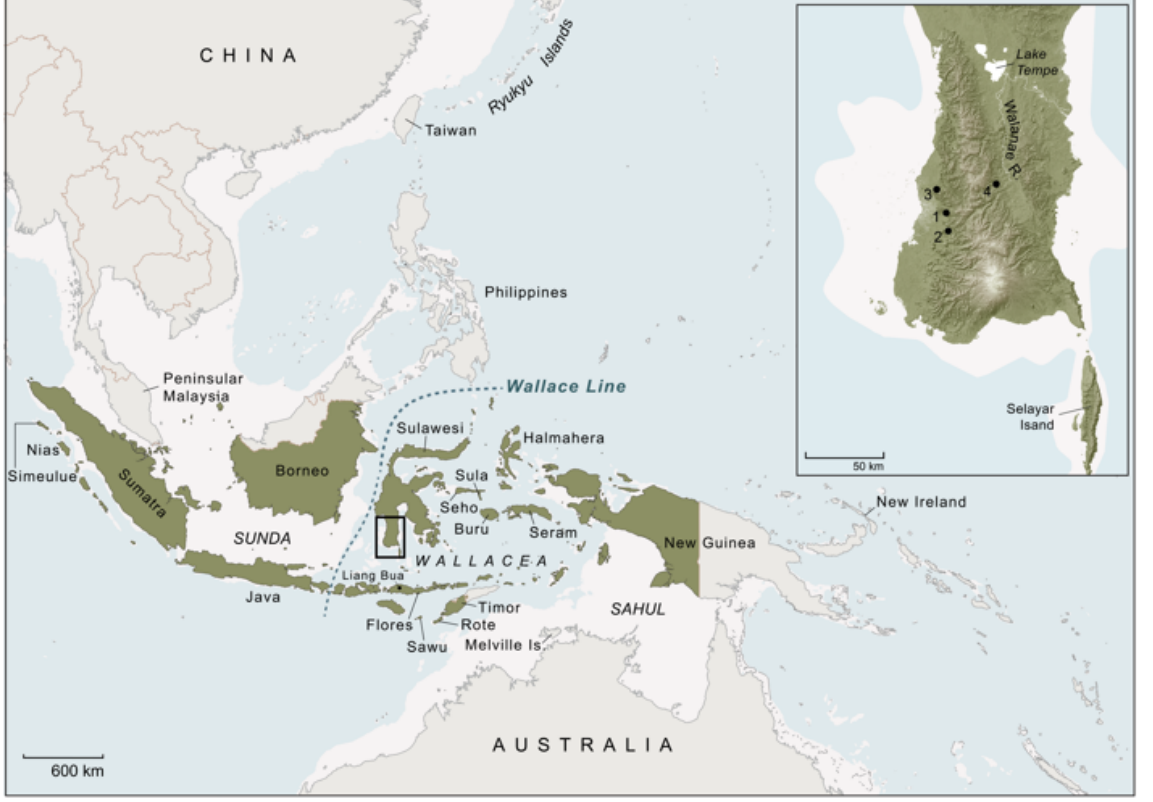
Figure 1. The Sulawesi warty pig ( Sus celebensis ). Characteristic morphological features include: 1 = head crest; 2 = preorbital facial warts; 3 = mandibular (gonial) warts and associated hair whorls; 4 = postorbital facial warts. The photographs were all taken in nature reserves on Sulawesi. The individual in ( c ) is an old male with pronounced postorbital facial warts. Image credits: ( a , b ), C.C. Lee; ( c ), A.H. Mustari.